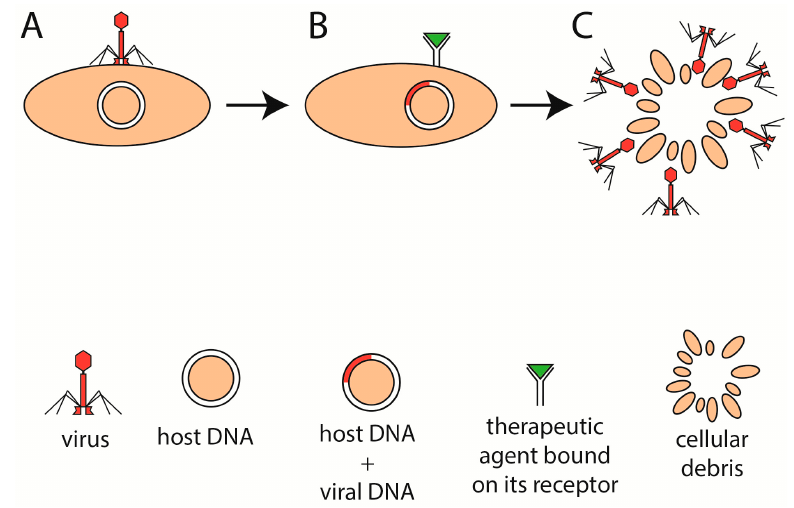
Figure 4. Modulation of phage therapy. The phage attaches to its host and incorporates its genetic information into the DNA of the host ( A ). If the bacterium was to be destroyed, for example, because of dysbiosis or pathogenicity, then the administration of a therapeutic agent ( B ) into the colon might induce the lytic cycle of the incorporated phages and subsequently degrade the bacterium ( C ).